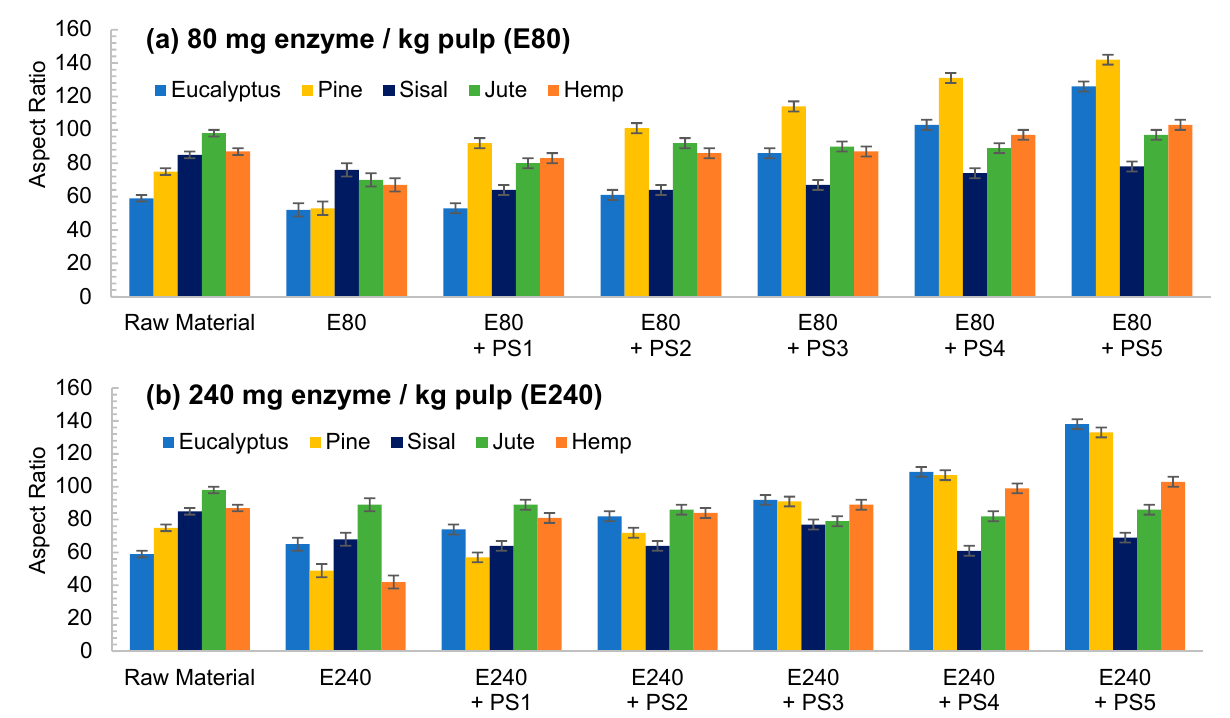
Figure 4. Evolution of aspect ratio in CMF/CNFs with enzymatic hydrolysis as pretreatment with different enzyme dose: